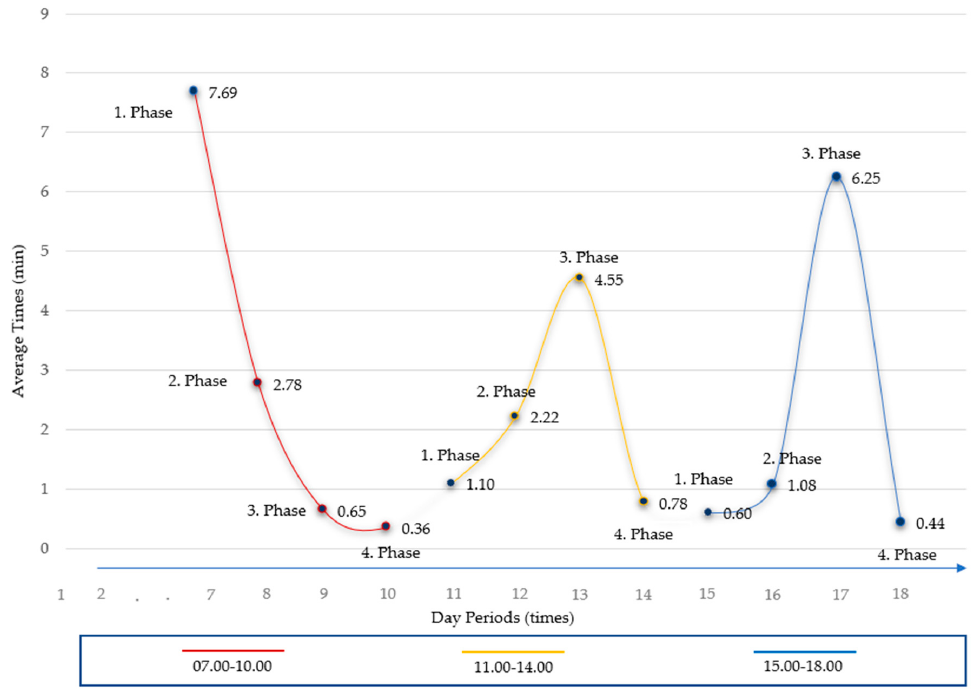
Figure 11. The changing average vehicle delays during different periods of a day.